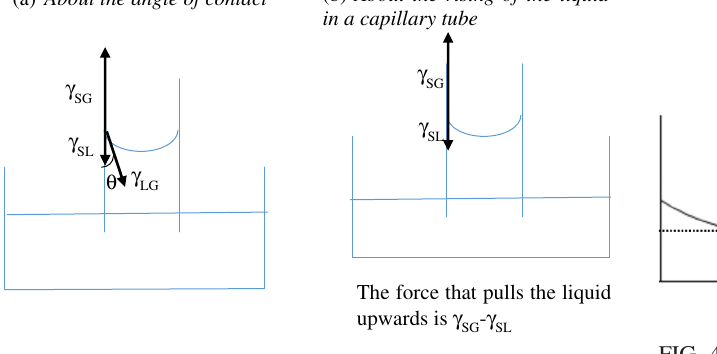
FIG. 3. (a) A current diagram introducing Young ’ s formula γ cos θ ¼ γ - γ , where γ , γ , and γ are the coefficients LG SG SL LG SG SL of interfacial tension (forces by unit length), corresponding, respectively, to liquid/gas, solid/gas, and solid/liquid interfaces, and where θ is the angle of contact. (b) A diagram often used to account for the rising of a liquid column in a capillary tube, with a comment [60].